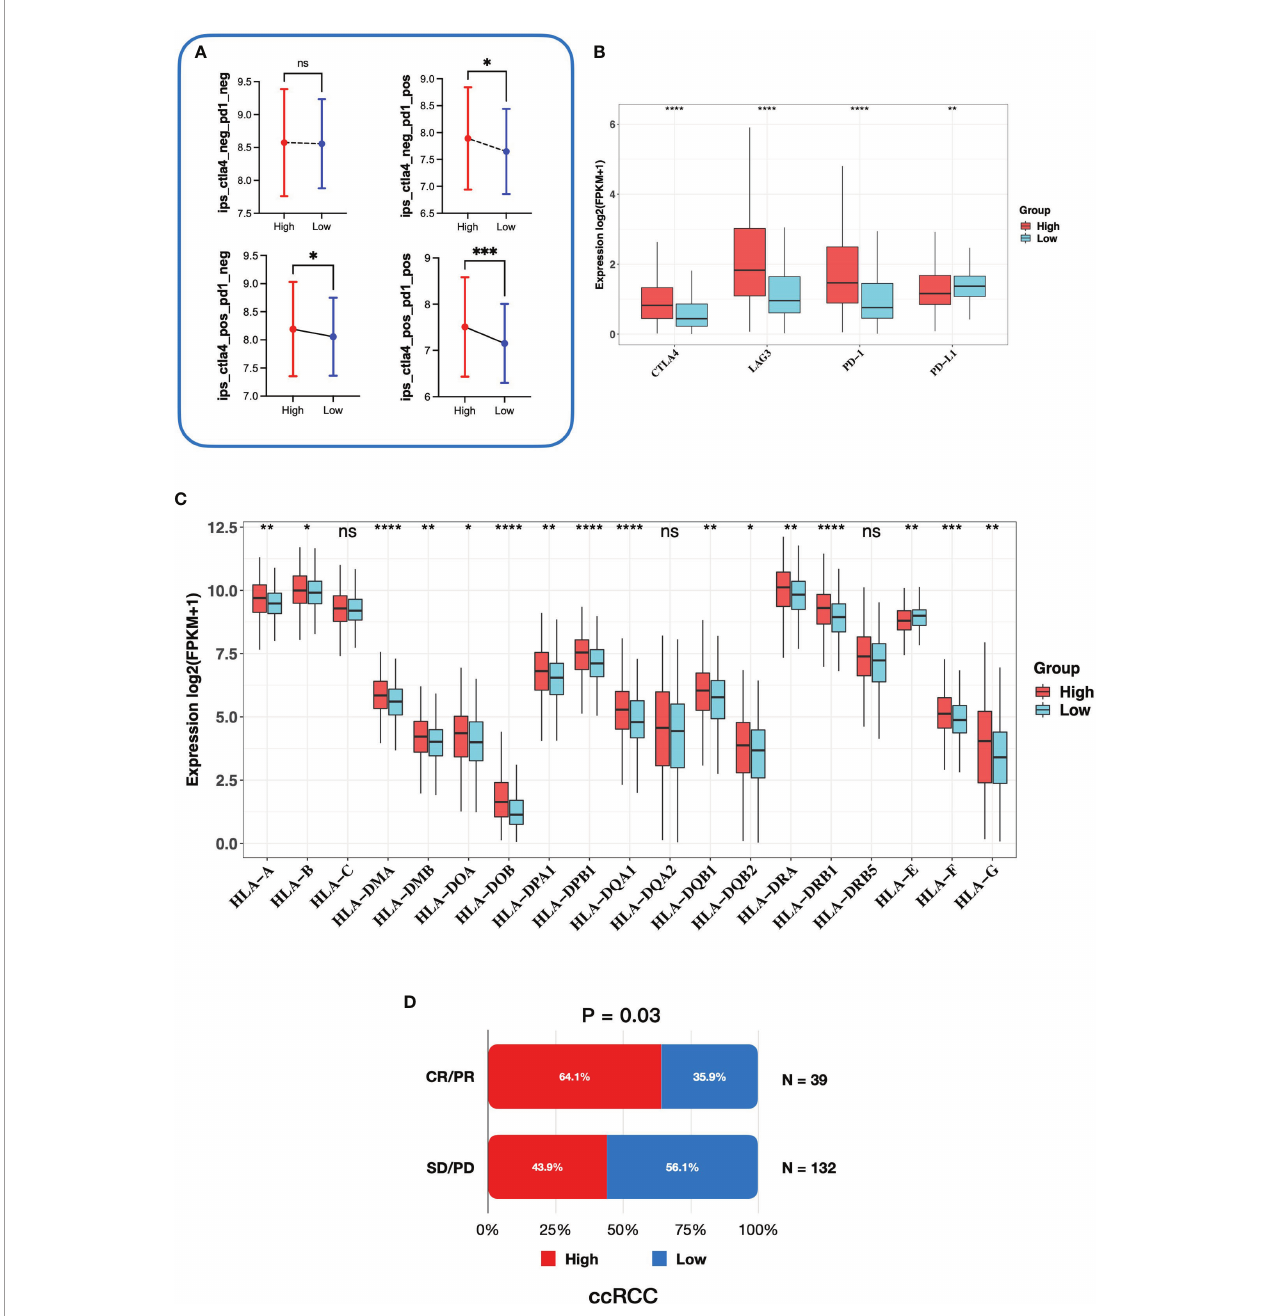
FIGURE 8 | Correlation between the gene signature and response to immunotherapy. (A) The relationship between immunophenoscore and the gene signature. (B) Expression of inhibitory immune checkpoints in high- and low-risk groups. (C) Expression of the HLA gene family in high- and low-risk groups. (D) The association between risk groups and response to anti-PD-1 antibody treatment in the ccRCC cohort. CR, complete response; PR, partial response; SD, stable disease; PD, progressive disease. * 0.01 < p < 0.05; ** 0.001 < p < 0.01; *** 0.0001 < p < 0.001; **** p < 0.0001; ns no signi fi